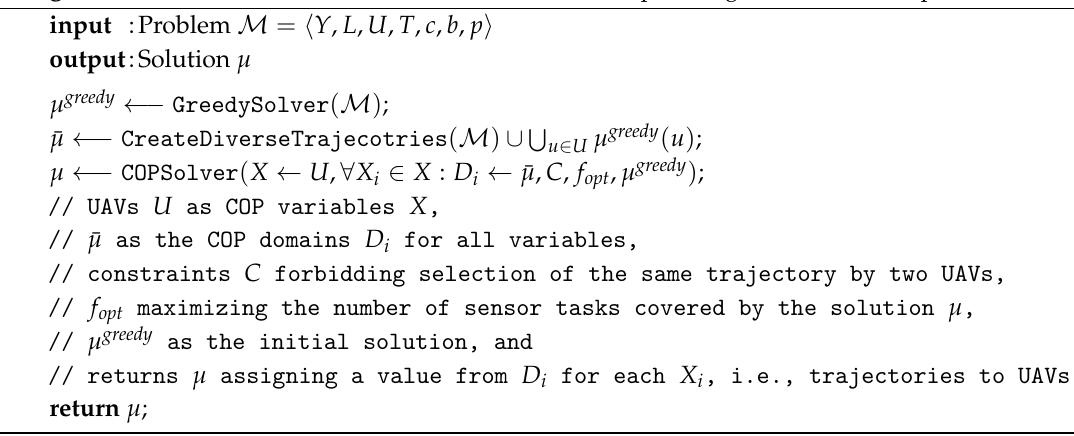
Algorithm 3: DivPlan —A MUSP solver based on diverse planning and constraint